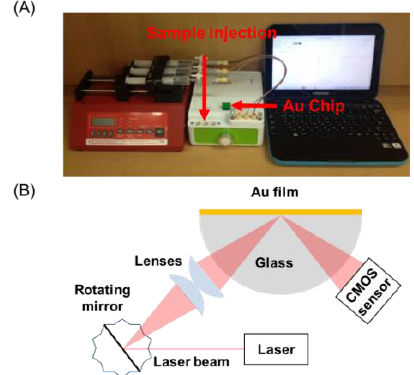
Figure 1. ( A ) Photograph of the portable surface plasmon resonance (SPR) system combined with a syringe pump and laptop. The Au chip was installed in the portable SPR system, and the sample solution was injected with the syringe pump. The SPR response was displayed on the laptop. ( B ) Schematic illustration of the portable SPR system based on the modulation of laser light by a rotating